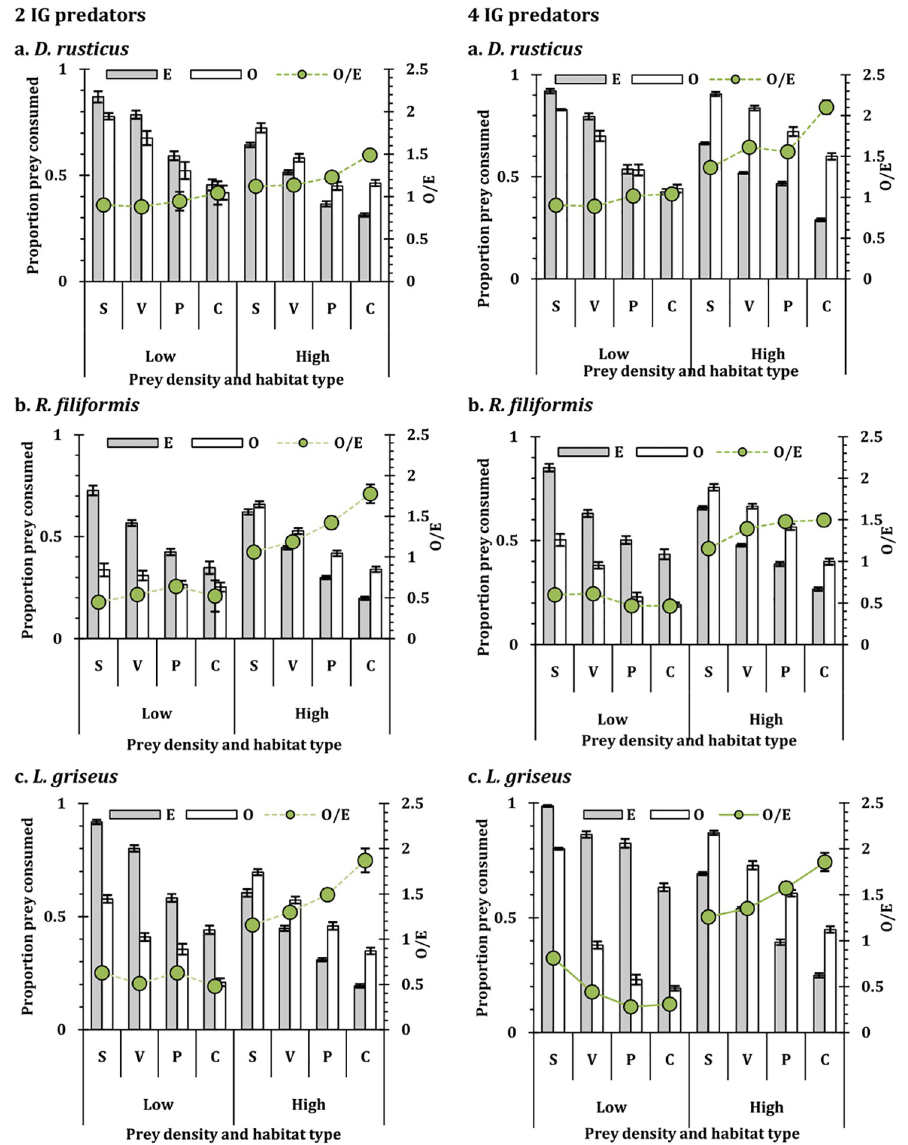
shared prey mortality. S = Simple; V = Only macrophytes; P = only pebbles; C = Complex; E = Expected value; O = Observed value; O/E = Observed/ expected